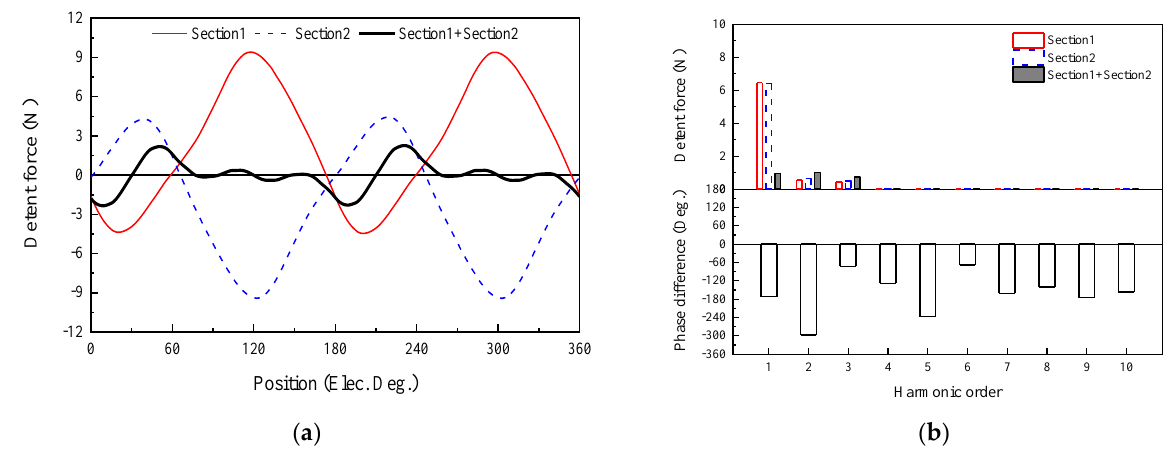
Figure 6. Detent force of Model 2: ( a ) detent force waveforms by sections; ( b ) detent force frequency decomposition.